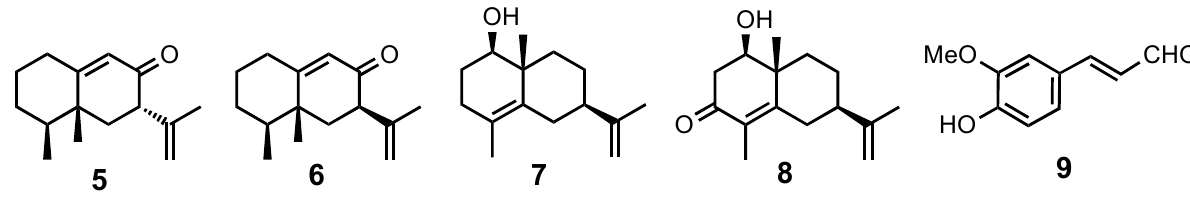
Figure 3. Known compounds isolated in this work.